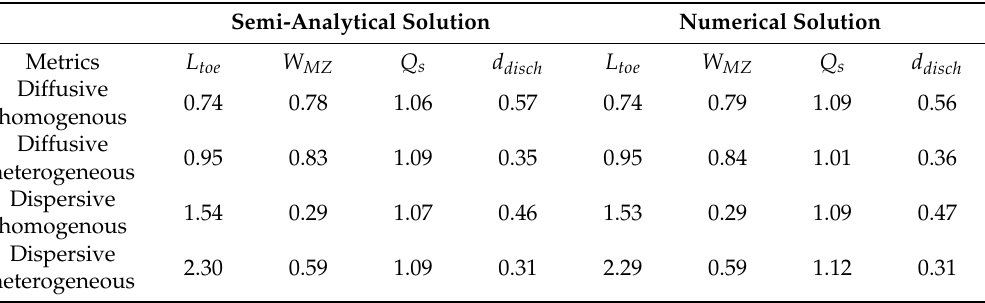
Table 3. Physical parameters used in the numerical model for the verification test cases ( L toe : length of the toe, W MZ : average vertical width of the mixing zone, Q S : total dimensionless salt flux, d disch : depth of the zone of groundwater discharge to the